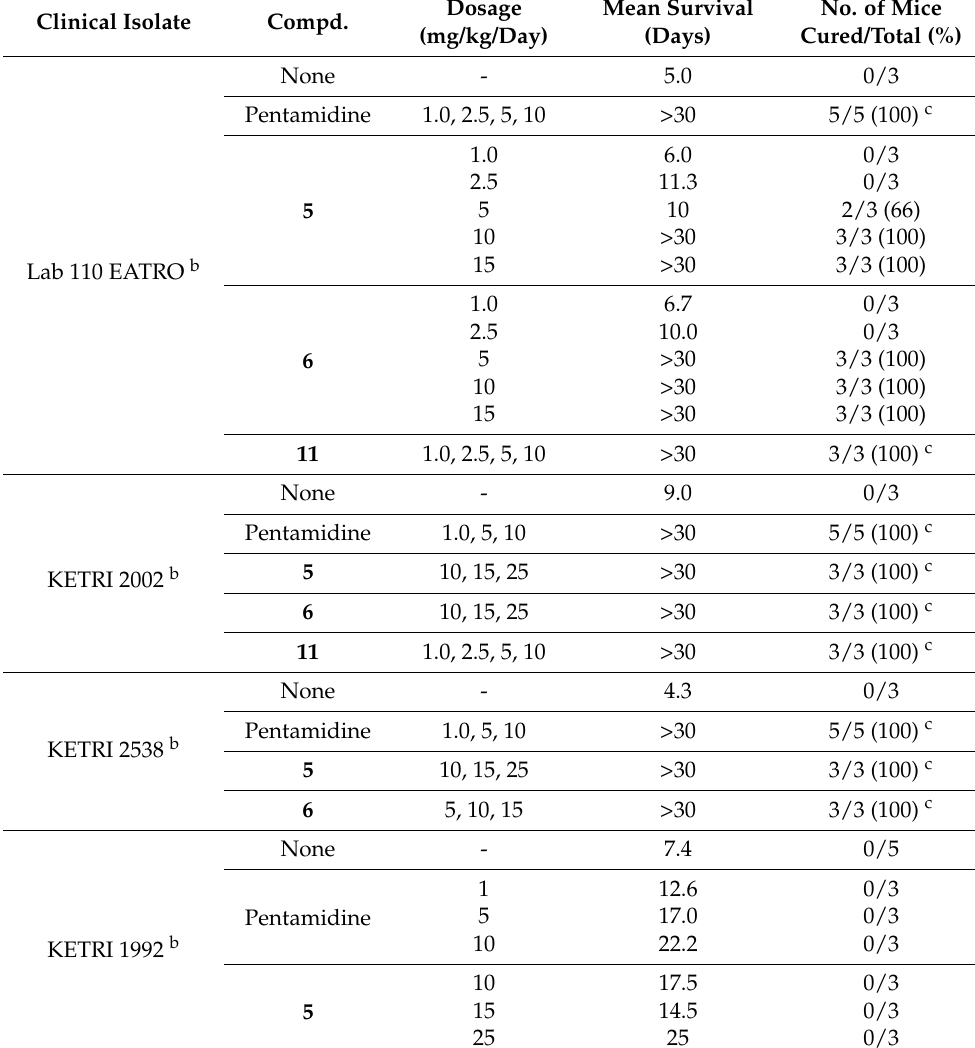
Table 3. In vivo trypanocidal activity of selected compounds in mice a . Clinical Isolate